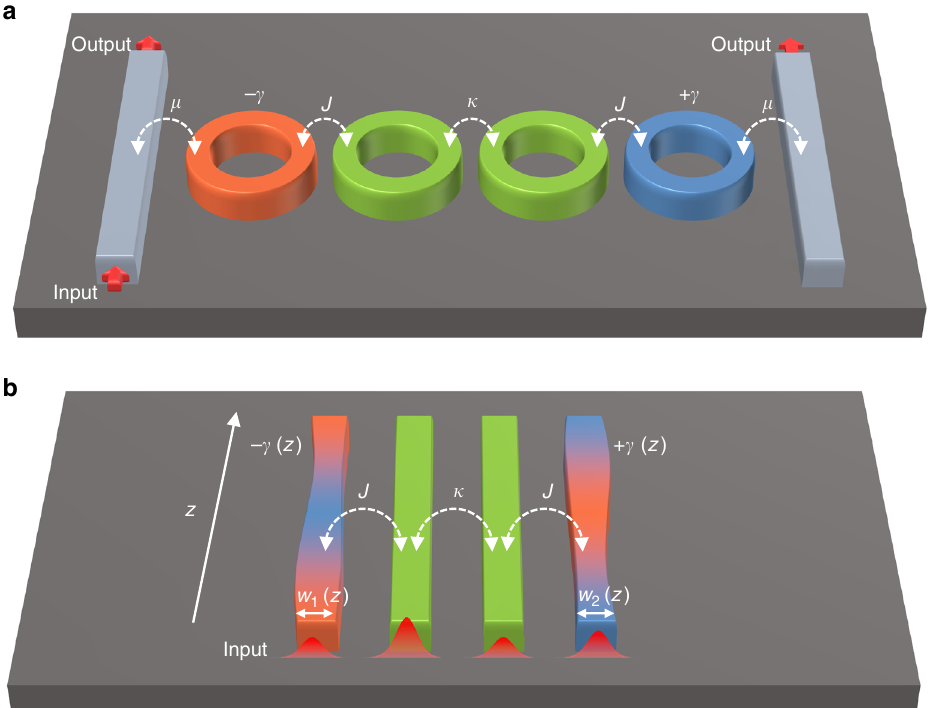
Fig. 7 Photonic implementations. Possible photonic platforms for implementing and testing the encircling of multiple exceptional points (EPs) in a microring resonators; and b waveguides. The gain/loss can be controlled via the pumping (represented schematically by different colors, orange for gain, blue for loss, and green for neutral.) while the coupling between adjacent elements can be tailored by engineering the edge-to-edge distance. Finally the resonant frequency (or propagation constants) can be tuned by varying the resonator (waveguide) dimensions. For stroboscopic encircling, several samples have to be fabricated, each of which corresponds to a different operating point. The eigenvalues are then plotted and connected smoothly to form the adiabatic loop as having been done before 24 – 26 . The dynamic encircling on the other hand requires changing the parameter of one sample as a function of time (distance) in resonators (waveguides) platforms. Panel b illustrates how this can be achieved in waveguides. Particularly, the propagation constants can be varied along the prorogation distance z by changing waveguide dimensions, such as the width for example. The gain/loss can be controlled along z by engineering the spatial pro fi le of the optical pump. White arrows indicate the coupling while red thick arrows represent the input/output